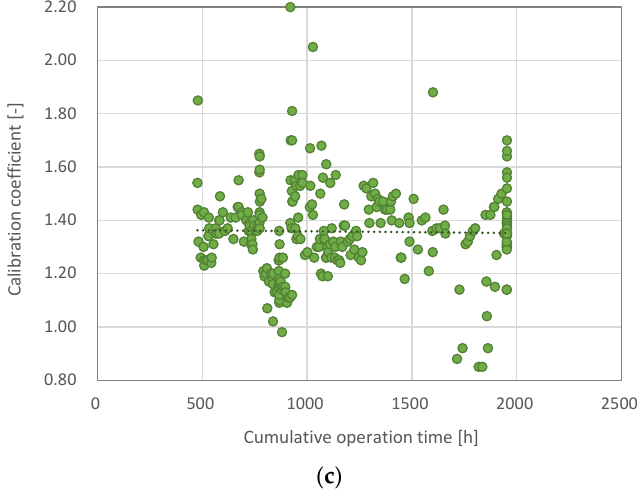
Figure 3. Calibration coefficient values according to cumulative operating time of cooling towers: